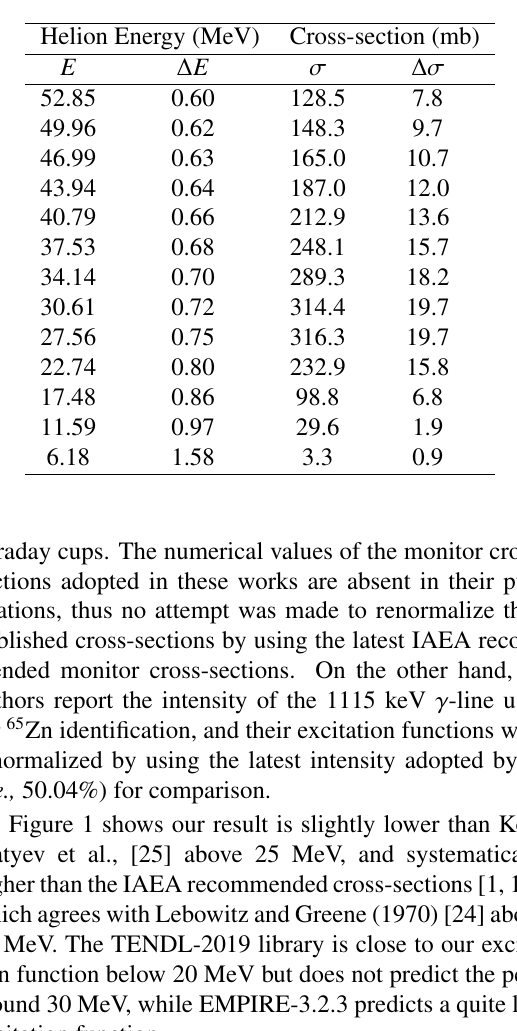
Table 1. Measured cross-sections of nat Cu( 3 He,x) 65 Zn